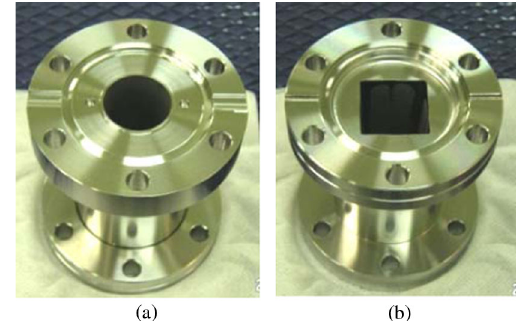
FIG. 9. Photograph of the rf fingers with Al windows in (a) active mode and (b) shelter mode. The beam direction is from right to left.